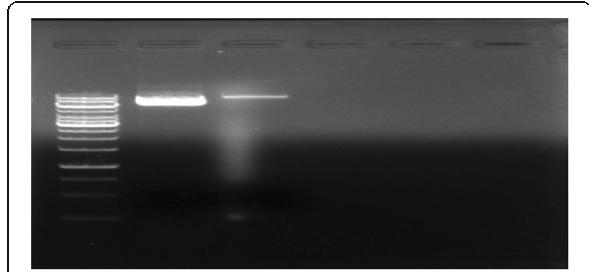
Fig. 3 1% agarose gel of undigested and digested pAc vector